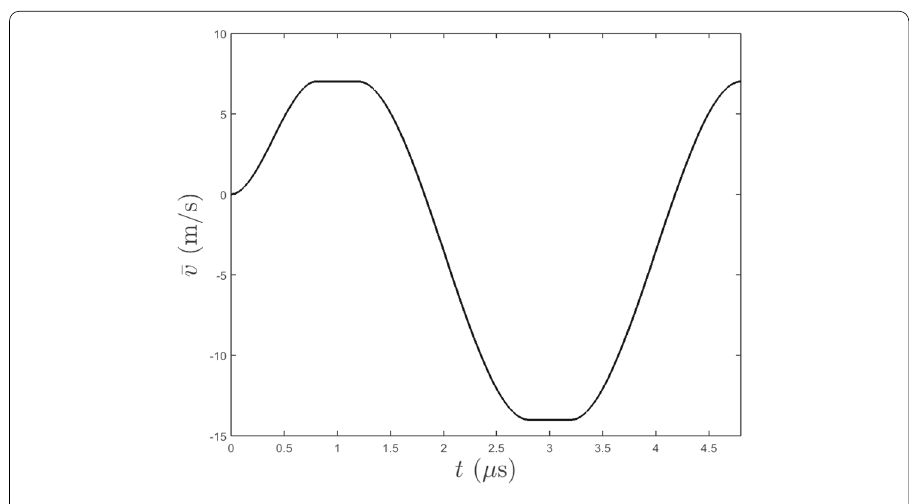
Fig. 5 Load history for nonplanar crack growth problem: ¯ v ( t ) interfacepropertiesthatgoverndebondingandcontactare¯ s = 32 . 40MPa, s = 25 . 92MPa, ˜ τ = 250 ns, β = 1, and k = 0 . 25. The contact regularization parameters are ¯ δ = 0 and δ = − 100 nm. The displacement scale for this example is ˜ δ = 10 μ m, and the normalized regularization interval is δ (cid:8) ≈ 0 . 01. This satisfies the condition, δ (cid:8) (cid:9) 1, to ensure that the contact regularization does not significantly influence the